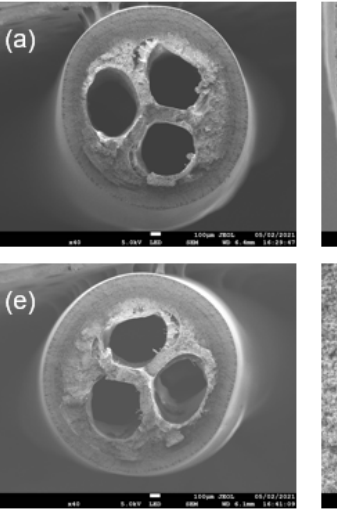
Figure 5. FESEM images of tri-bore PVDF hollow fiber membranes fabricated from batch sizes of ( a – d ) 20 kg and ( e – h ) 50 kg. ( a , e ) Cross section, ( b , f ) cross section at higher magnification, ( c , g ) inner surface, ( d , h ) outer surface. The PVDF surfaces were sputter-coated with platinum before measure- ment.